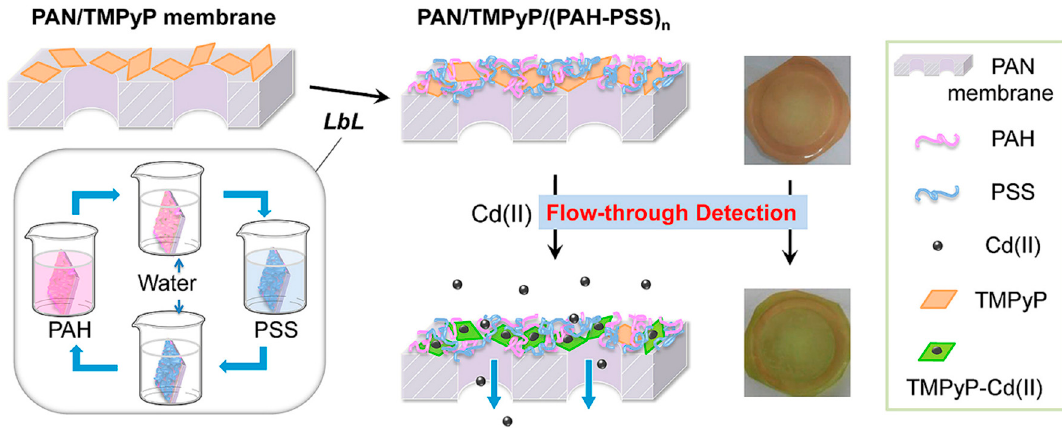
Figure 9. Schematic model of optical sensor membrane fabrication and flow-through detection of Cd 2+ ions. Reprinted with permission from ref [45]. Copyright 2019 Elsevier Ltd. All rights reserved.